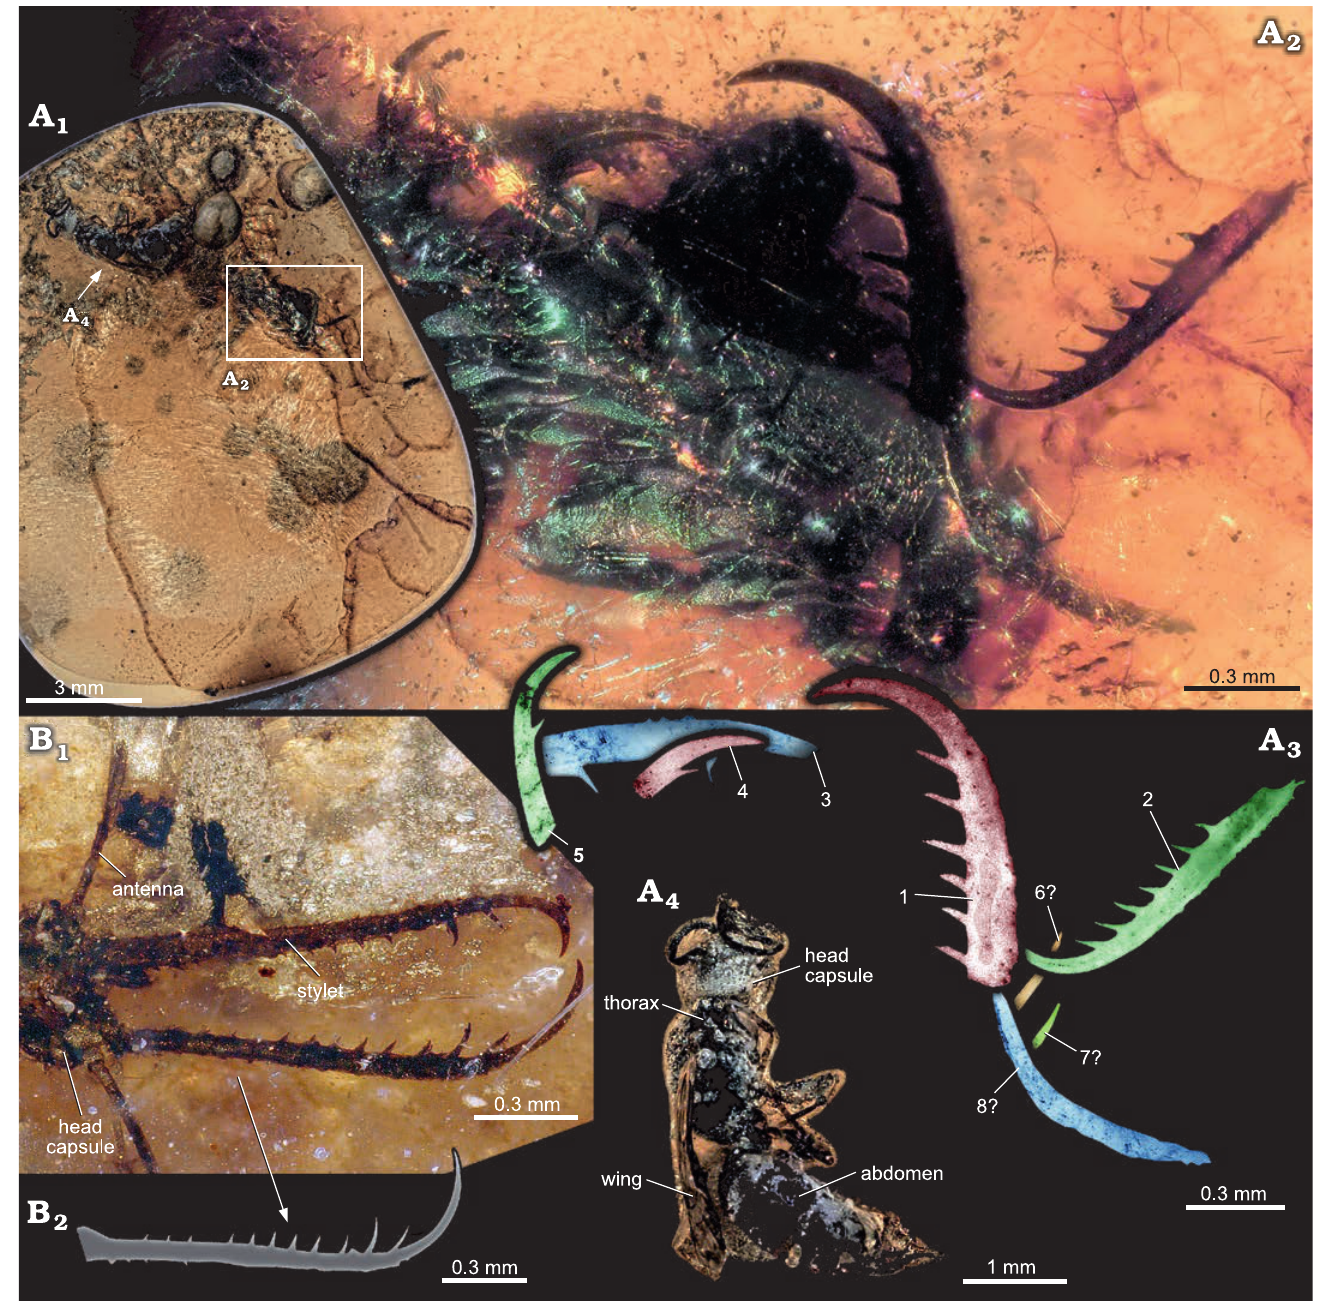
Fig. 1. Neuropteran larvae from Hukawng Valley, Kachin State, Myanmar; Turonian–Ceno manian, Cretaceous, 90–100 mya. A . SNSB-BSPG 2020 XCIII 19 with assemblage of neuropteran stylets; A 1 , overview; A 2 , close-up image of enclosed stylets; A 3 , stylets, with five clearly visible (1–5) and possibly three additional stylets (6?–8?); A 4 , close-up image of representative of Hymenoptera. B . SNSB-BSPG 2020 XCIII 26 (previously BUB 033 in Haug et al. 2019c); B 1 , head of neuropteran larva with stylets pair in situ; B 2 , drawing of a single stylet of the specimen in B 1 ; note the high number of teeth, similar to that of stylets 1 and 2 in A 3